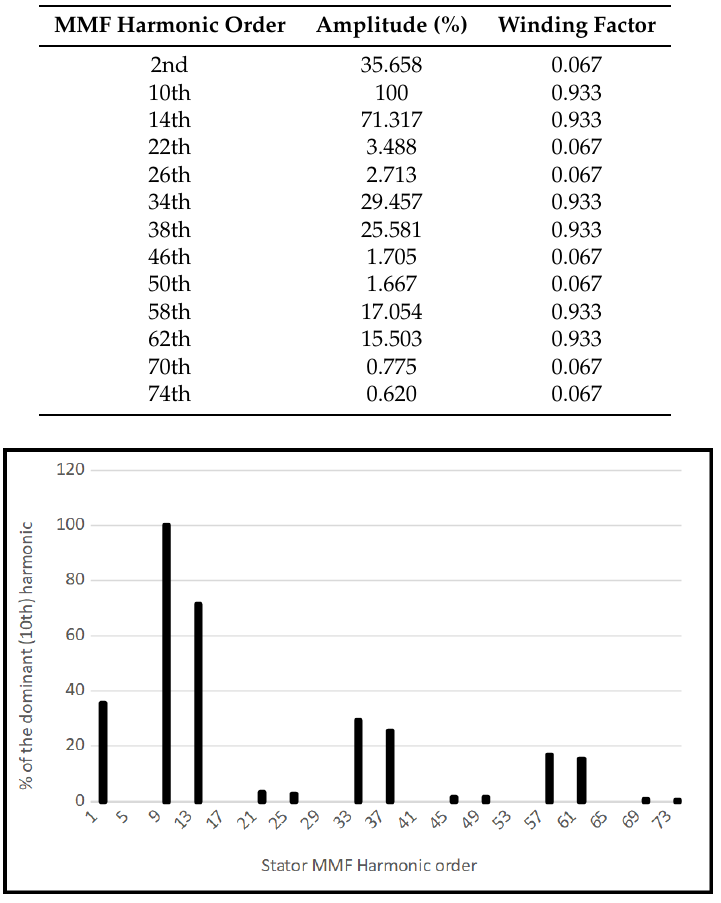
Table 2. Amplitude (%) and winding factor of MMF space harmonics.